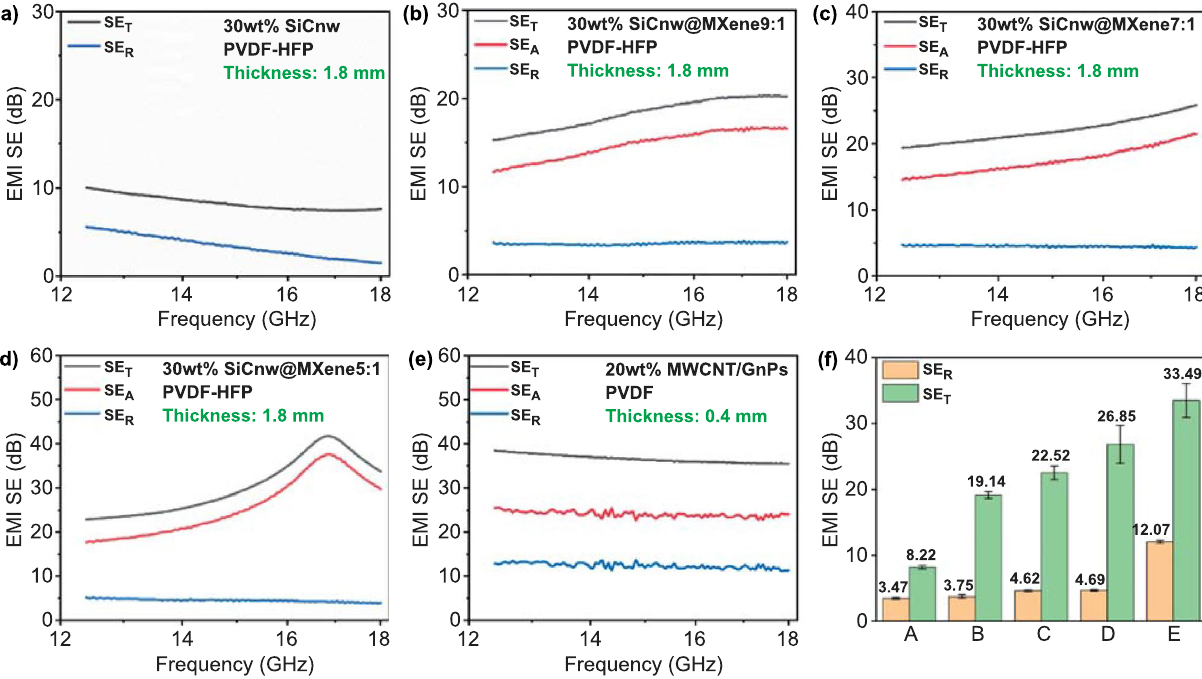
Fig. 4 a‑d EMI shielding performance of PVDF/30 wt% SiCnw@MXene nanocomposites with various filler compositions; e EMI shielding performance of PVDF/10 wt% MWCNT/10 wt% GnPs nanocomposite; f Average SE R and SE T of PVDF nanocomposites from